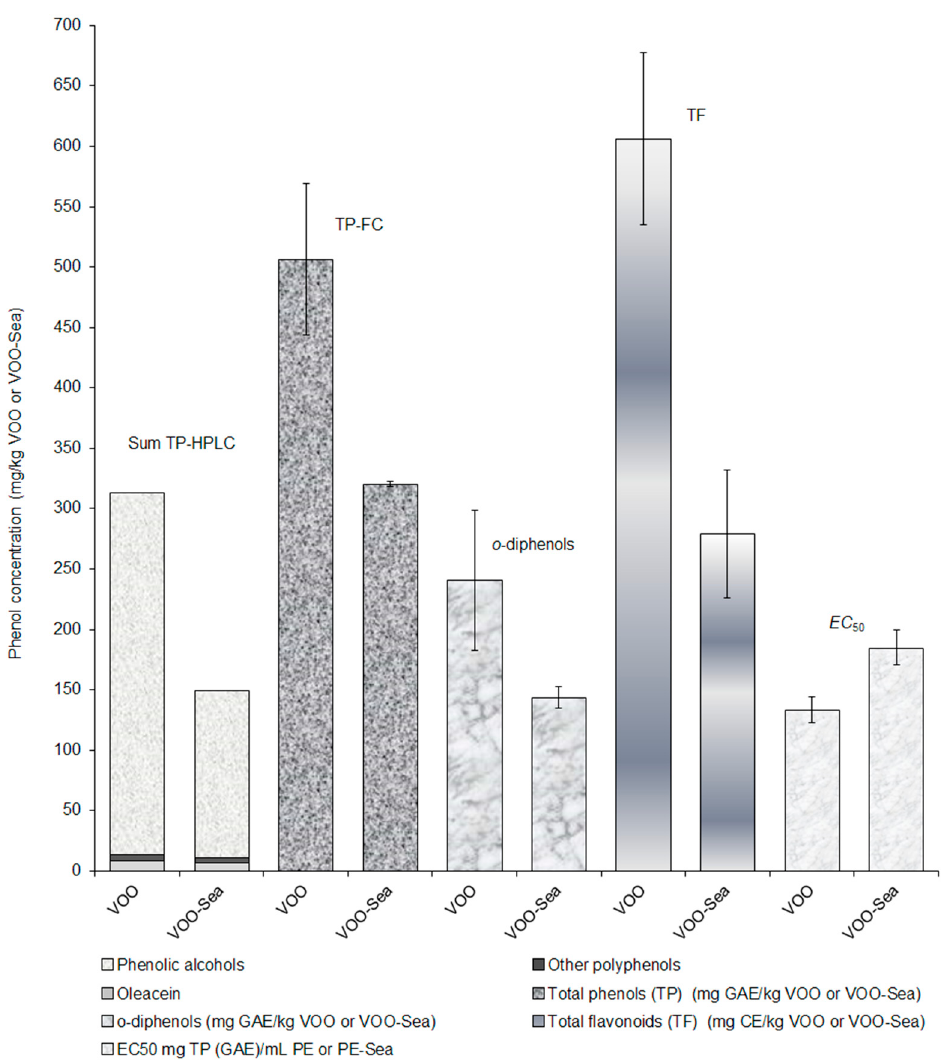
Figure 3. Comparison of phenolic concentrations and EC 50 value in VOO and VOO-Sea. Sum TP-HPLC, sum of total phenols determined by HPLC-DAD analysis; TP-FC, total phenols determined by Folin-Ciocalteu analysis; TF, total flavonoids; EC 50 , concentration of total phenols in PE or PE-Sea leading to 50% reduction of the initial DPPH concentration.